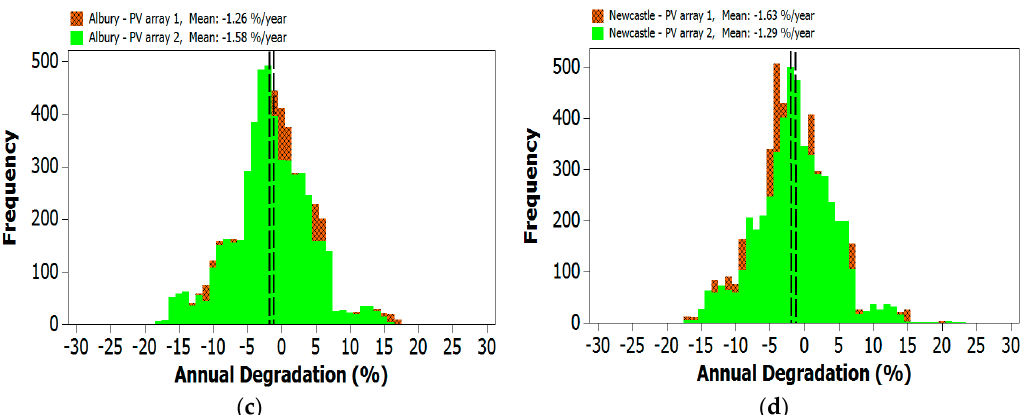
Figure 8. Analysis of the hot-spots and annual degradation rate in the Australian PV installations: ( a ) two PV modules affected by faulty bypass diodes in the second PV array—found in Albury PV system; ( b ) PV array 1 is affected by five hot-spotted PV modules, while PV array 2 is affected by one hot-spotted PV module—found in Newcastle PV system; ( c ) Albury PV site annual degradation rate; ( d ) Newcastle PV site annual degradation rate.